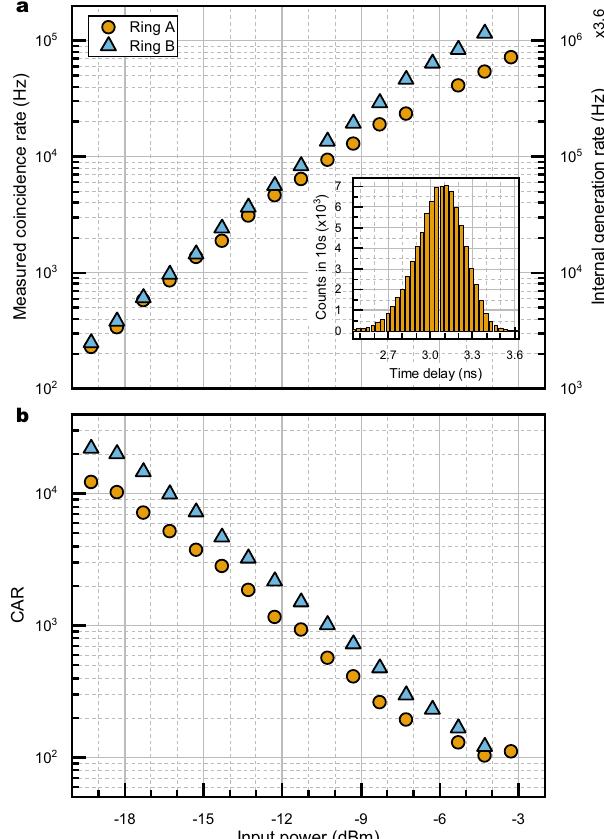
Fig.2|Spontaneousfour-wavemixing. Generationofpairsthroughspontaneous four-wave mixing using the tworings of the device. The twosets ofresonances are shiftedsuchthatalltheresonancesareseparated(con fi guration Ψ ).Atunablelaser is tunedon resonance with either Ring A orRing B,and the related signaland idler photons are detected. Similar coincidence rates ( a ) are observed, proving that the tworingshavesimilargenerationef fi ciencies.Insetshowsanexamplehistogramof thephotonarrivaltimedelays.Panel b showsthecalculatedCAR,whichexhibitsthe typical reductionfor the higher values of the input powerdue to the generationof higher-order photon